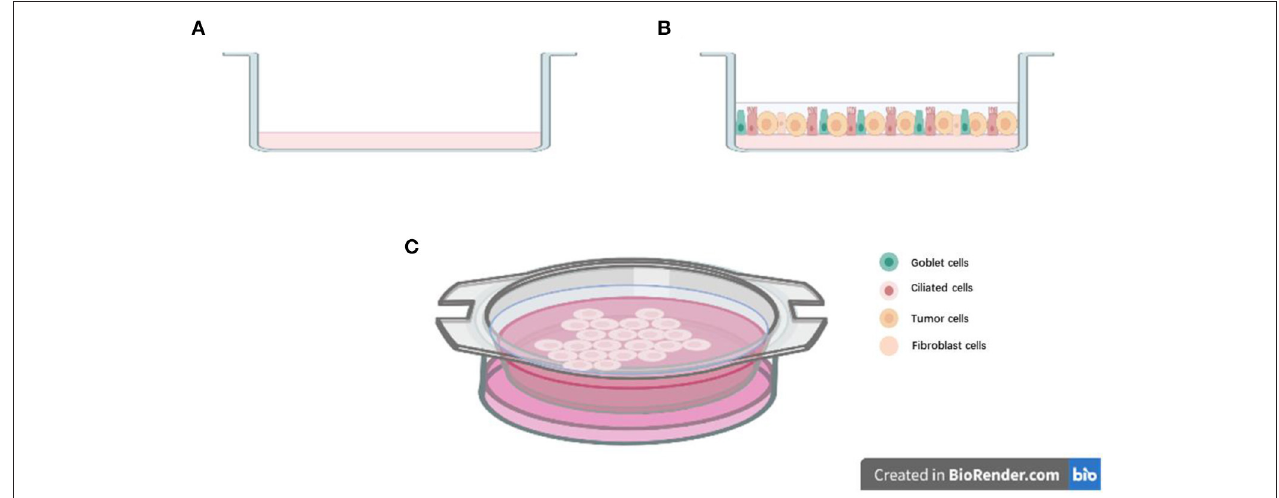
FIGURE 1 | Air-liquid interface (ALI) culture system: (A) Precoat collagen gel in a 0.4 µ m transwell; (B) Resuspend cells with collagen gel and layered on top of presolidified collagen gel; (C) Place the transwell into cell culture dish with culture medium.